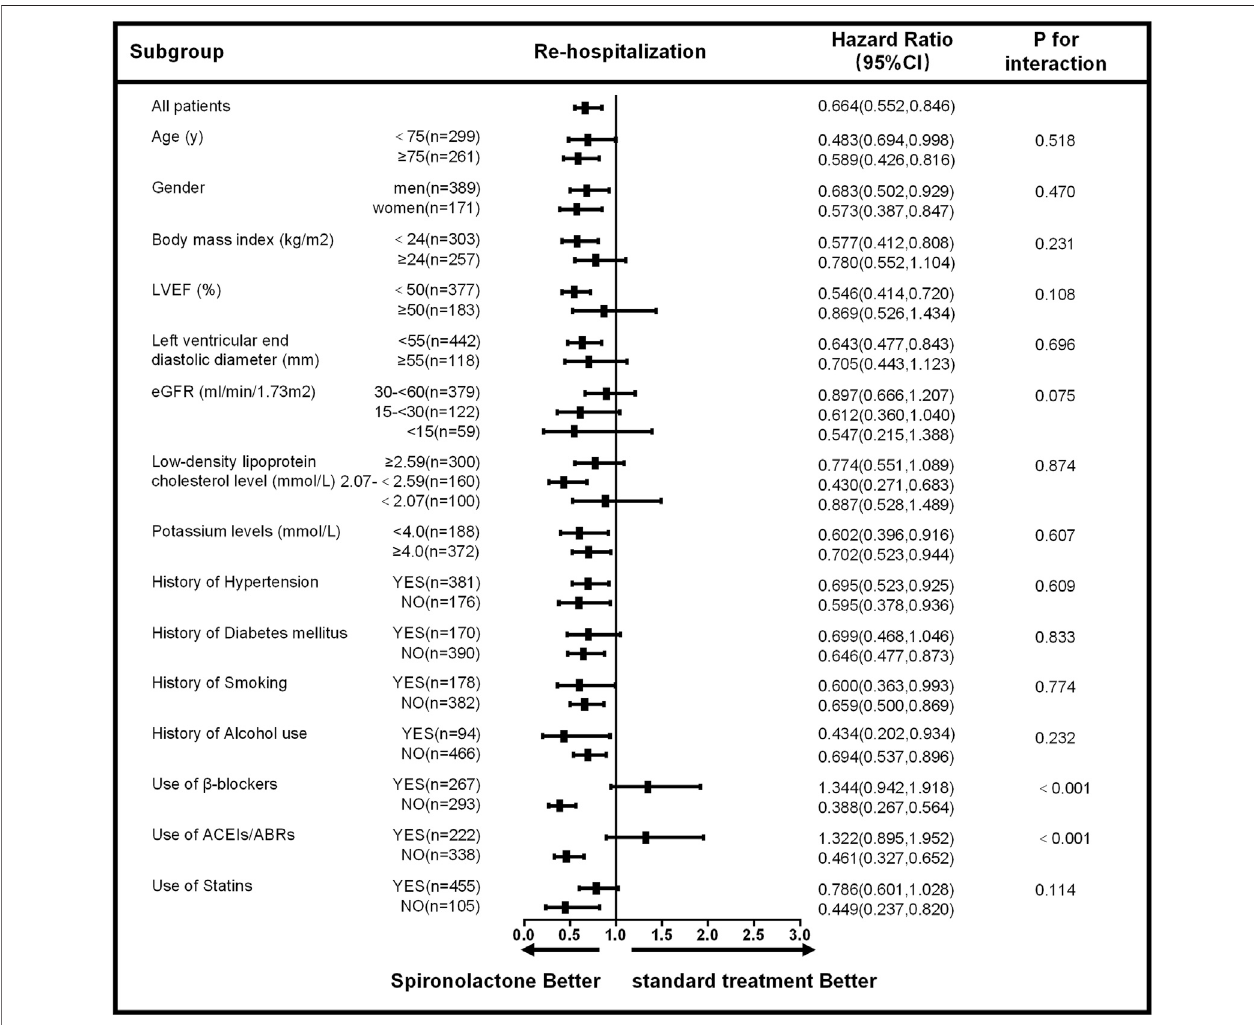
FIGURE4| Subgroupanalysisofre-hospitalizationbasedonlong-termfollow-up.LVEF,leftventricularejectionfraction;eGFR,estimated glomerular fi ltrationrate; ACEIs, angiotensin-converting enzyme inhibitors; ARBs, angiotensin receptor blockers; CI, con fi dence interval.